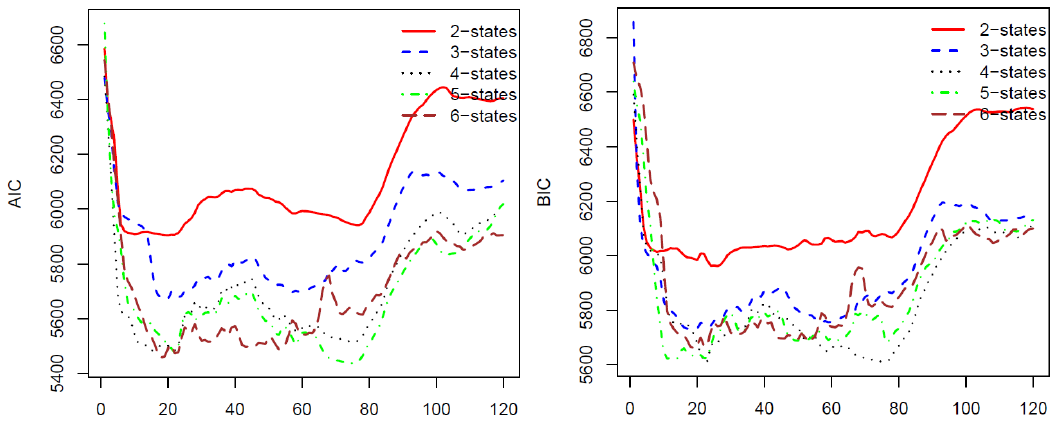
Figure 1. AIC ( left ) and BIC ( right ) for 120 HMM’s parameter calibrations using S&P 500 monthly prices.